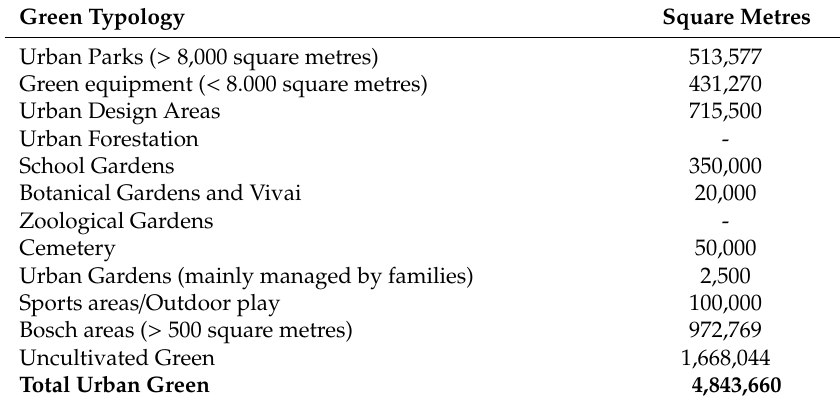
Table 1. The urban green spaces of the city of Catania (*). Green